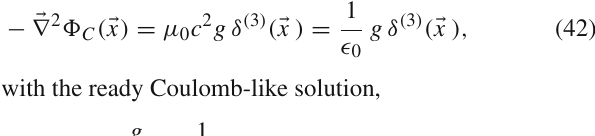
Table 1 Parity (P) and time reversal (T) property assignments for elec- tromagnetic